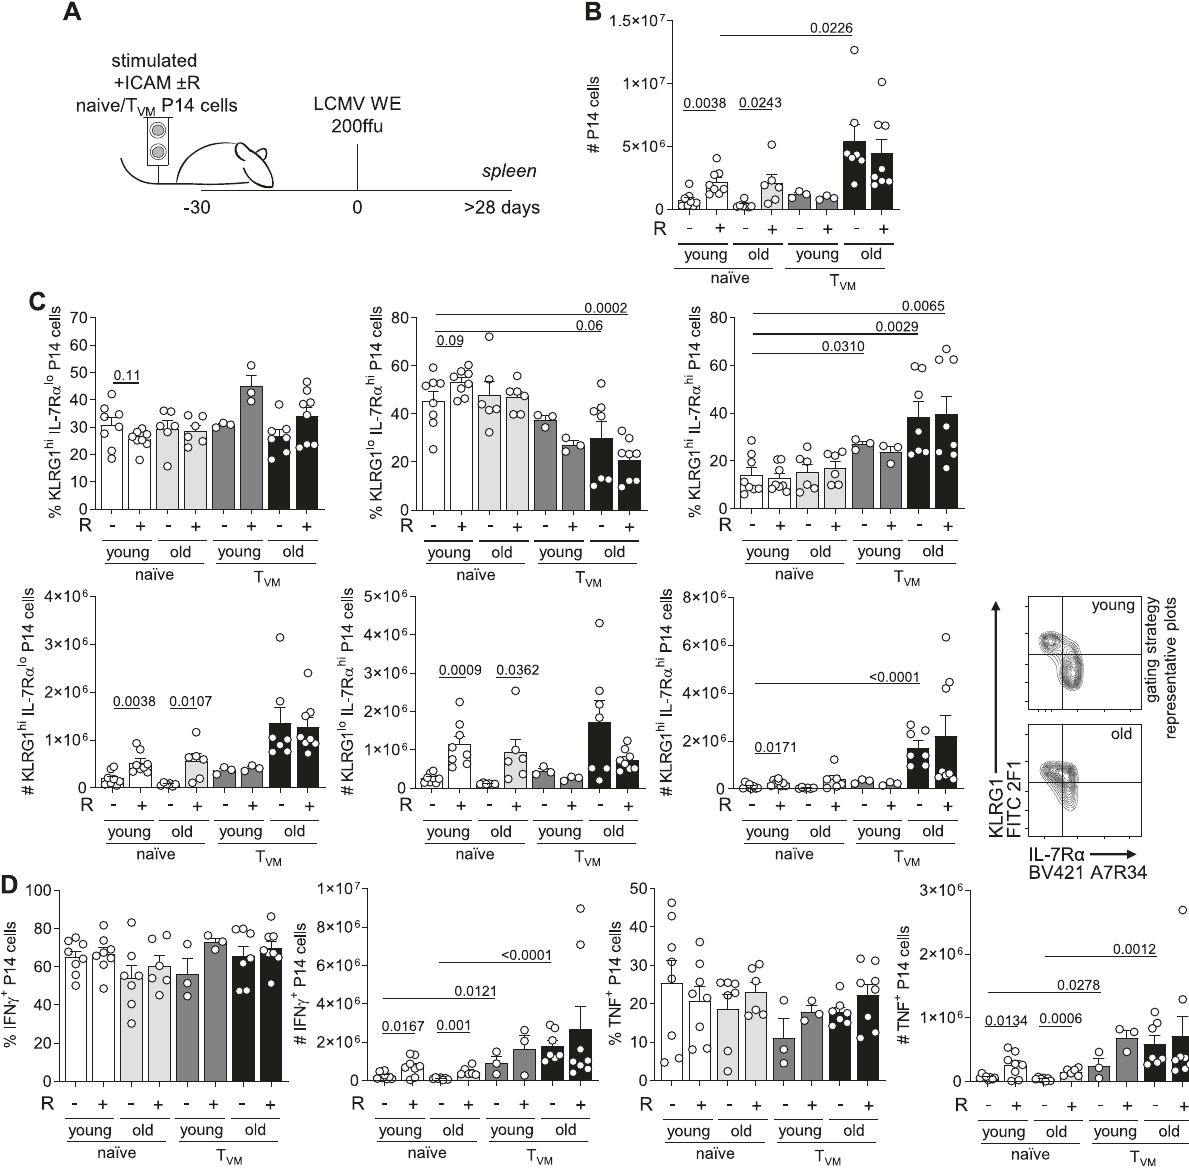
Fig. 5 Re-establishment of ACD by transient mTOR inhibition in naive CD8 + T cells from aged mice re fl ects in correlates with improved memory potential. A Experimental setup (illustration by MB). Naive and T VM CD8 + T cells were sorted from young and old P14 mice spleens, stimulated under different conditions, harvested after 36 h and adoptively transferred into wild-type recipients. Each recipient mouse received 1 × 10 4 cells and was infected intravenously with LCMV-WE (200 ffu) 30 days later. B Numbers of adoptively transferred P14 cells within CD8 + T cells in the spleens of recipient mice. Representative plots showing gating strategy used to access expression of KLRG1 and IL-7R α (right panel). D Frequencies and numbers of IFN γ , TNF and IL-2 producing cells in the spleens of recipient mice. Pooled data from two independent experiments (young naive, n = 8; young naive R, n = 8; young T VM , n = 3; young